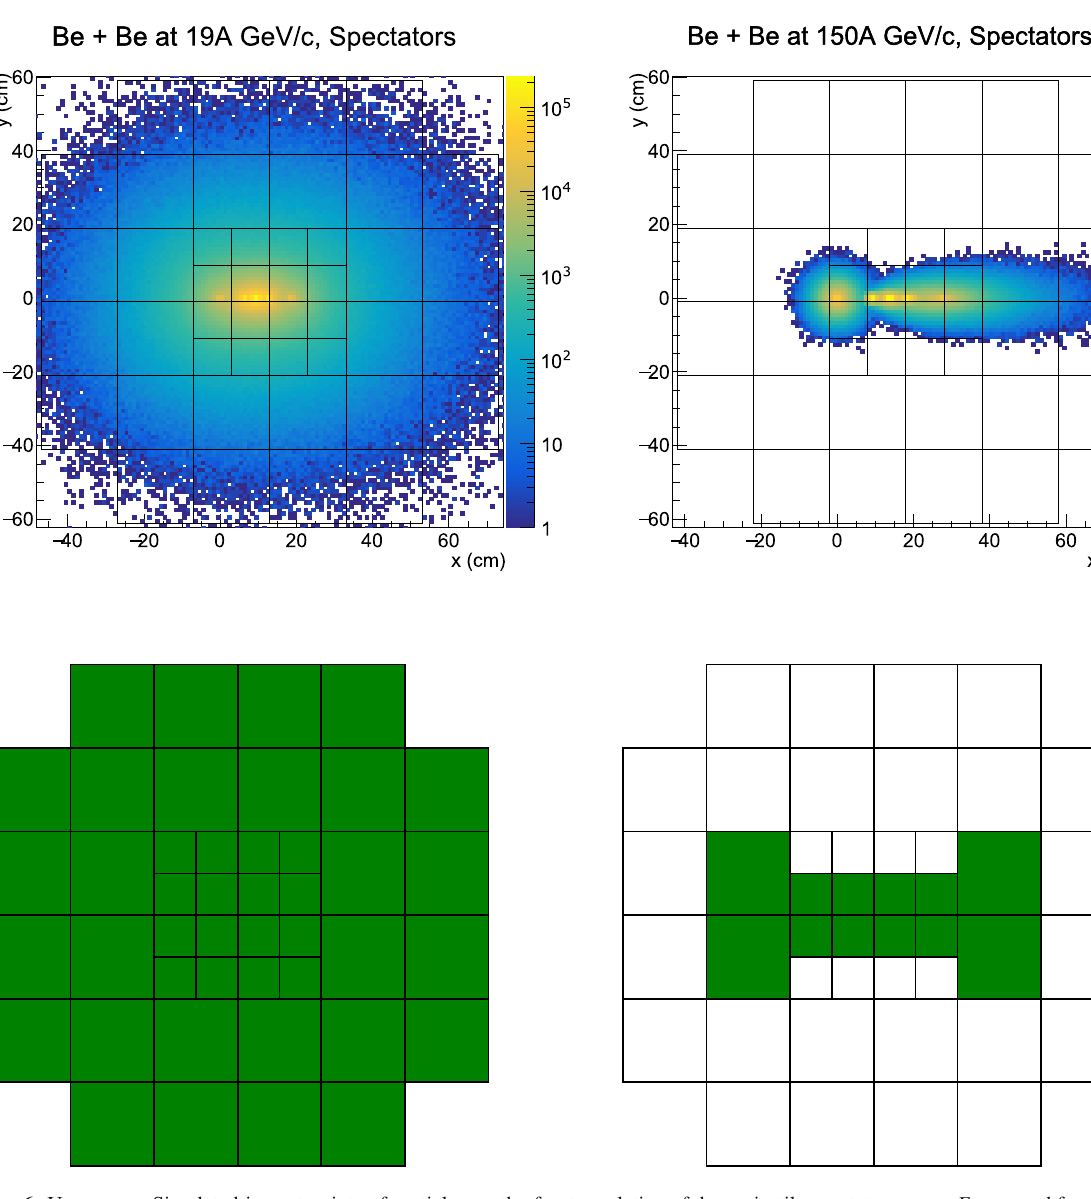
lation of the projectile spectator energy E PSD used for event selection for beam momenta of 19 A , and 30 A GeV / c (left) and for 40 A , 75 A and 150 A GeV / c (right)